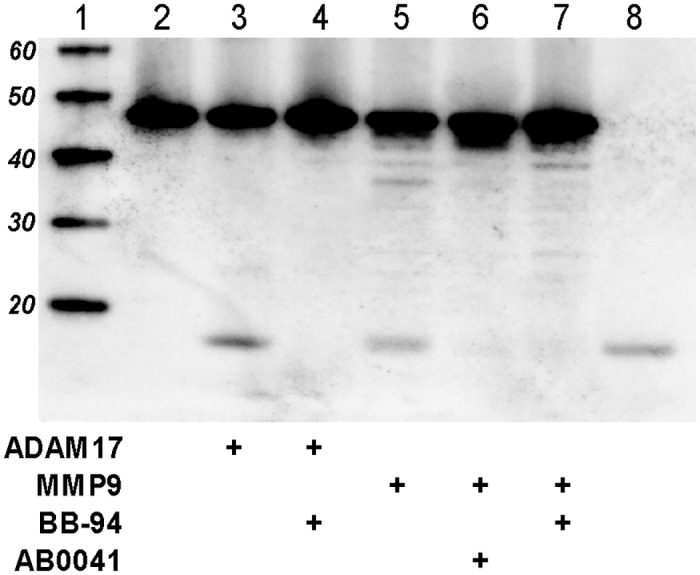
Anti-MMP9 antibody reduces soluble TNF-α generation.To assess cleavage, 2 μg of pro-TNF-α was incubated with either 2 μg ADAM17 or 2 μg MMP9 in the presence or absence of inhibitor. Cleavage reactions were allowed to incubate overnight at 37°C and were then analyzed by immunoblotting. Lanes are as follows: 1. Molecular weight markers, 2. Pro-TNF-α alone, 3. Pro-TNF-α + ADAM17, 4. pro-TNF-α + ADAM17 + BB-94 (10 μM), 5. Pro-TNF-α + MMP9, 6. Pro-TNF-α + MMP9 + AB0041 (10 μM), 7. Pro-TNF-α + MMP9 + BB-94 (10 μM), 8. Soluble TNF-α.